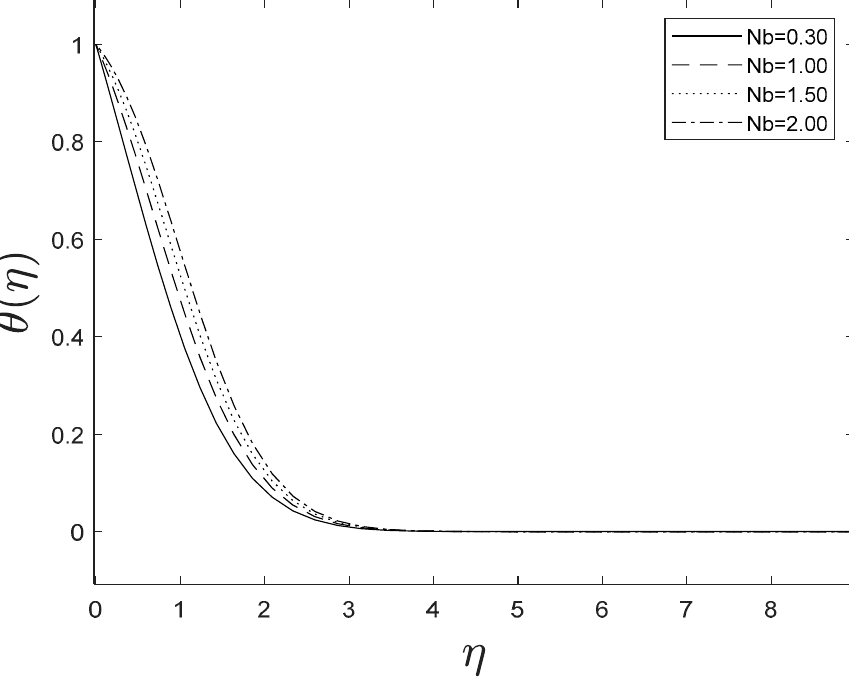
Figure 10. Effect of different values of V on φ ( η ) . Figures 11 and 12 reveal the implications of the Brownian motion parameter Nb on temperature and concentration fields. Brownian motion, in particular, aids in the heating of the fluid in the boundary layer and the restriction of particle evacuation from the fluid on the surface. As a result, the temperature increases while the concentration decreases.